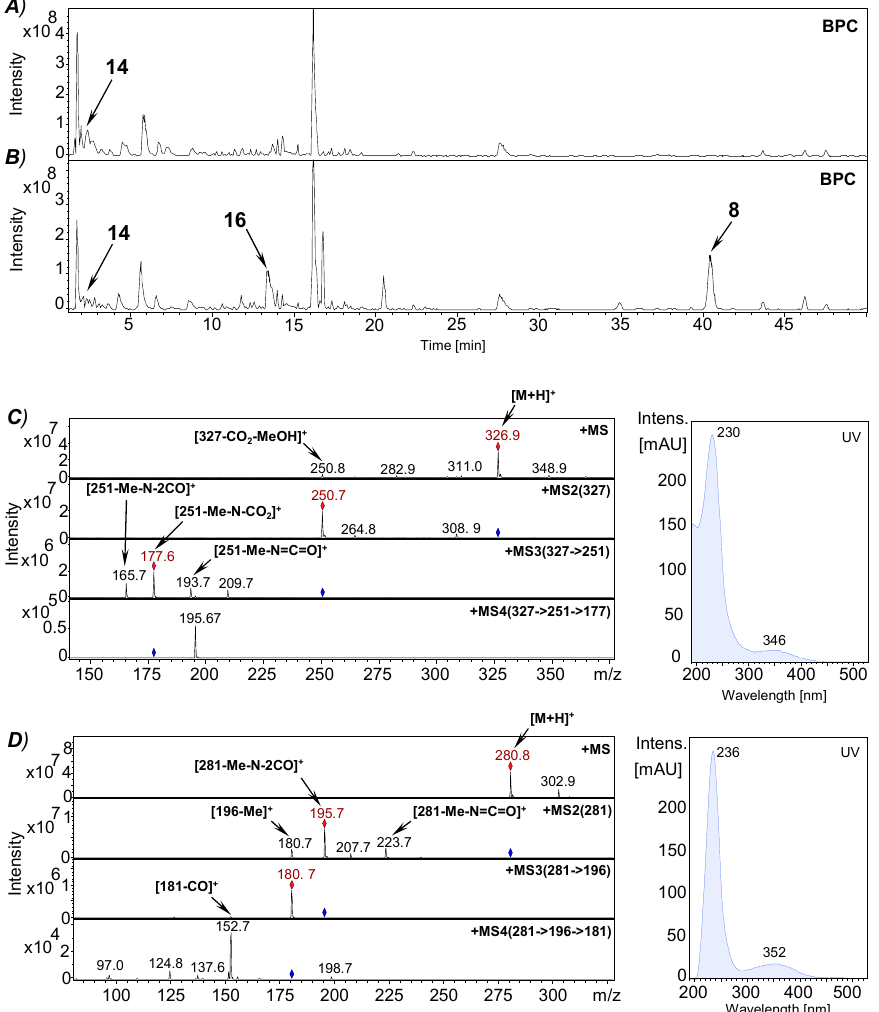
Figure 10. Detection of isochrysohermidinic acid ( 14 ), intermediate 16 and plicatanin B ( 8 ) in an unfermented and Pediococcus sp. (PP1) fermented aqueous extract from M. perennis roots. ( A ) Section of an LC-MS profile (BPC, positive ionization mode) of the unfermented extract. ( B ) LC-MS profile of the fermented extract (14 d). ( C ) MS n data of 16 (C 13 H 14 N 2 O 8 ; Mw 326.26 Da). ( D ) MS n data of 8 (C 12 H 12 N 2 O 6 ; Mw 280.23 Da). UV spectra of the respective compounds are illustrated on the right.